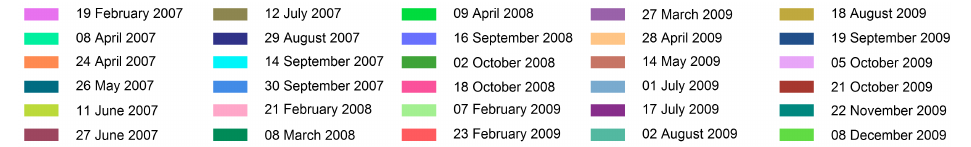
Figure A1. Color table for the Landsat disturbance detection results.